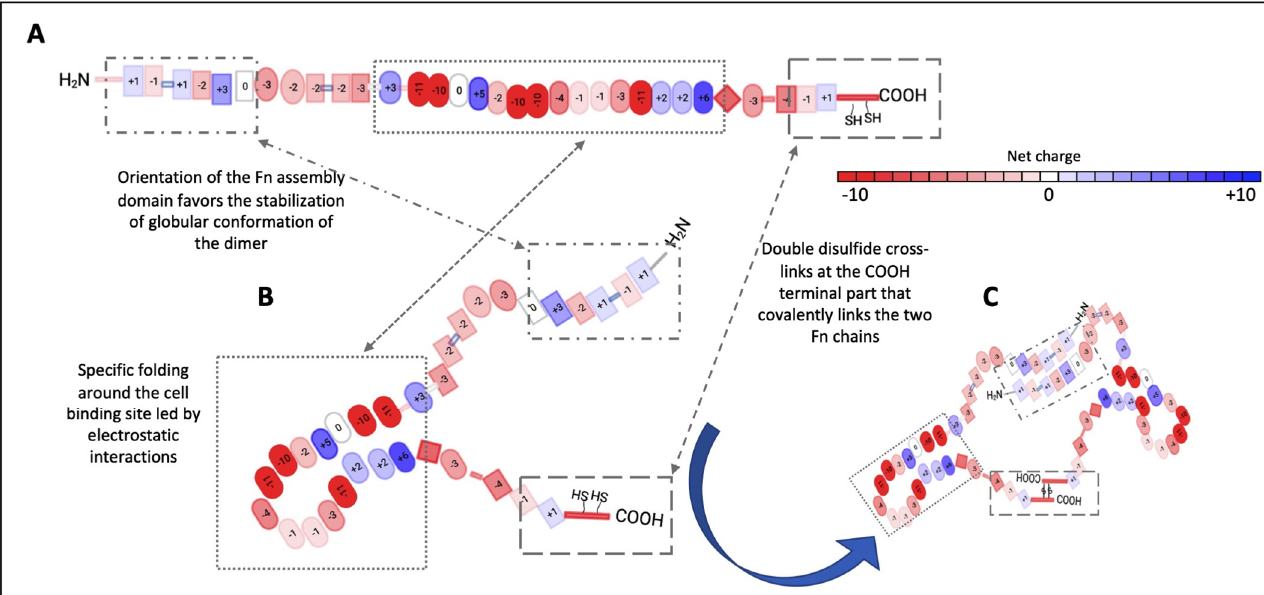
Figure 2. ( A ) Representation of the modular composition of an Fn chain with details of the electrostatic net charge for each of individual 32 domains. A red–blue scale illustrates the gradual change in the charge from –11 to +11. ( B ) Schematic representation of the structural organization adopted by the chain in solutions, essentially mediated by electrostatic domain interactions in the type III–1–III–14 central domains. ( C ) Representation of an Fn dimer stabilized by disulfide cross-links at the C-terminus and Fn–Fn interactions in the N-terminal domain.